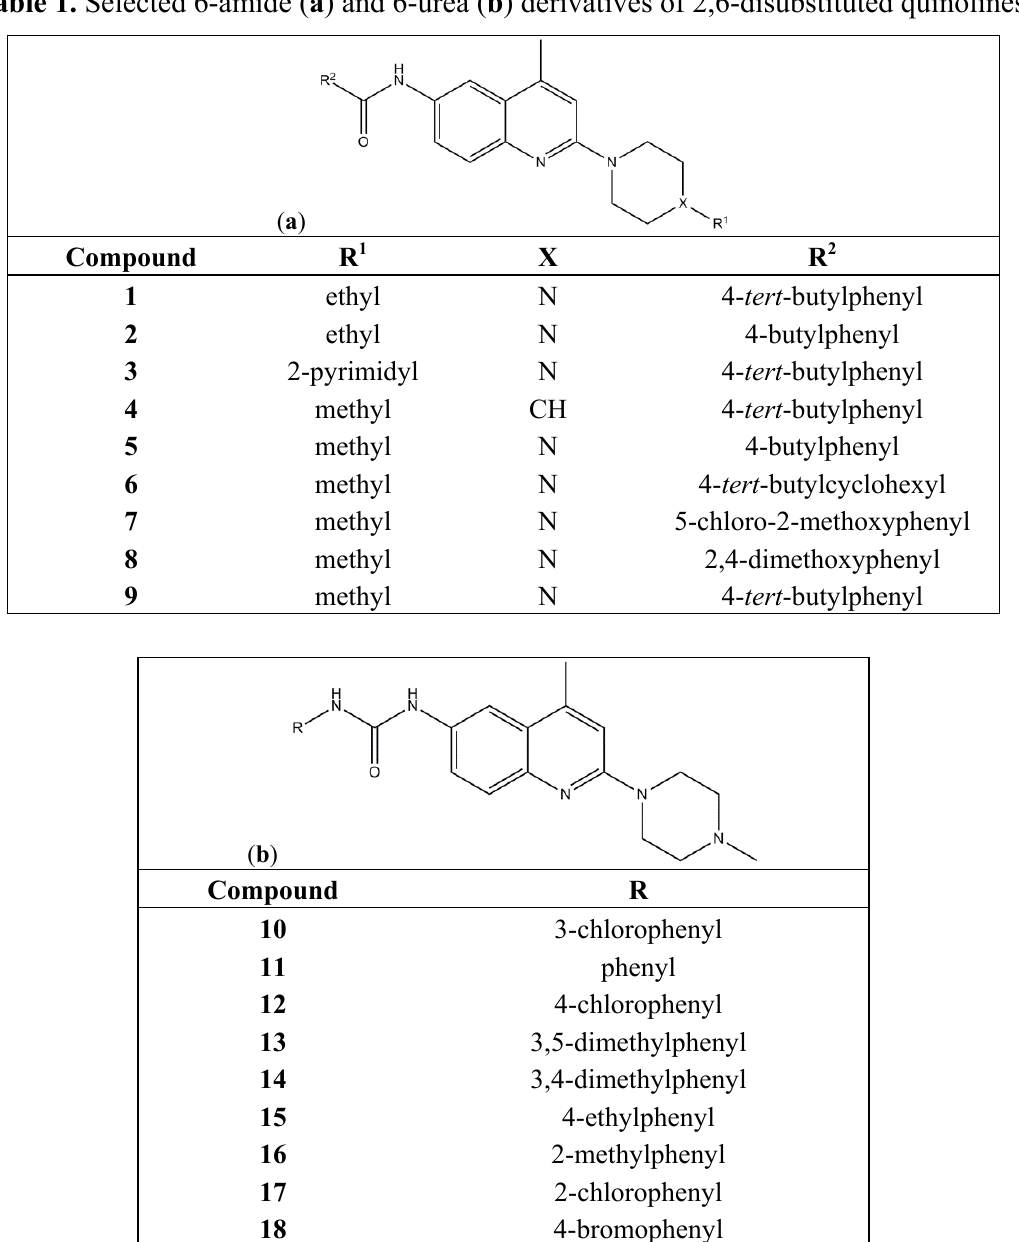
Table 1. Selected 6-amide ( a ) and 6-urea ( b ) derivatives of 2,6-disubstituted